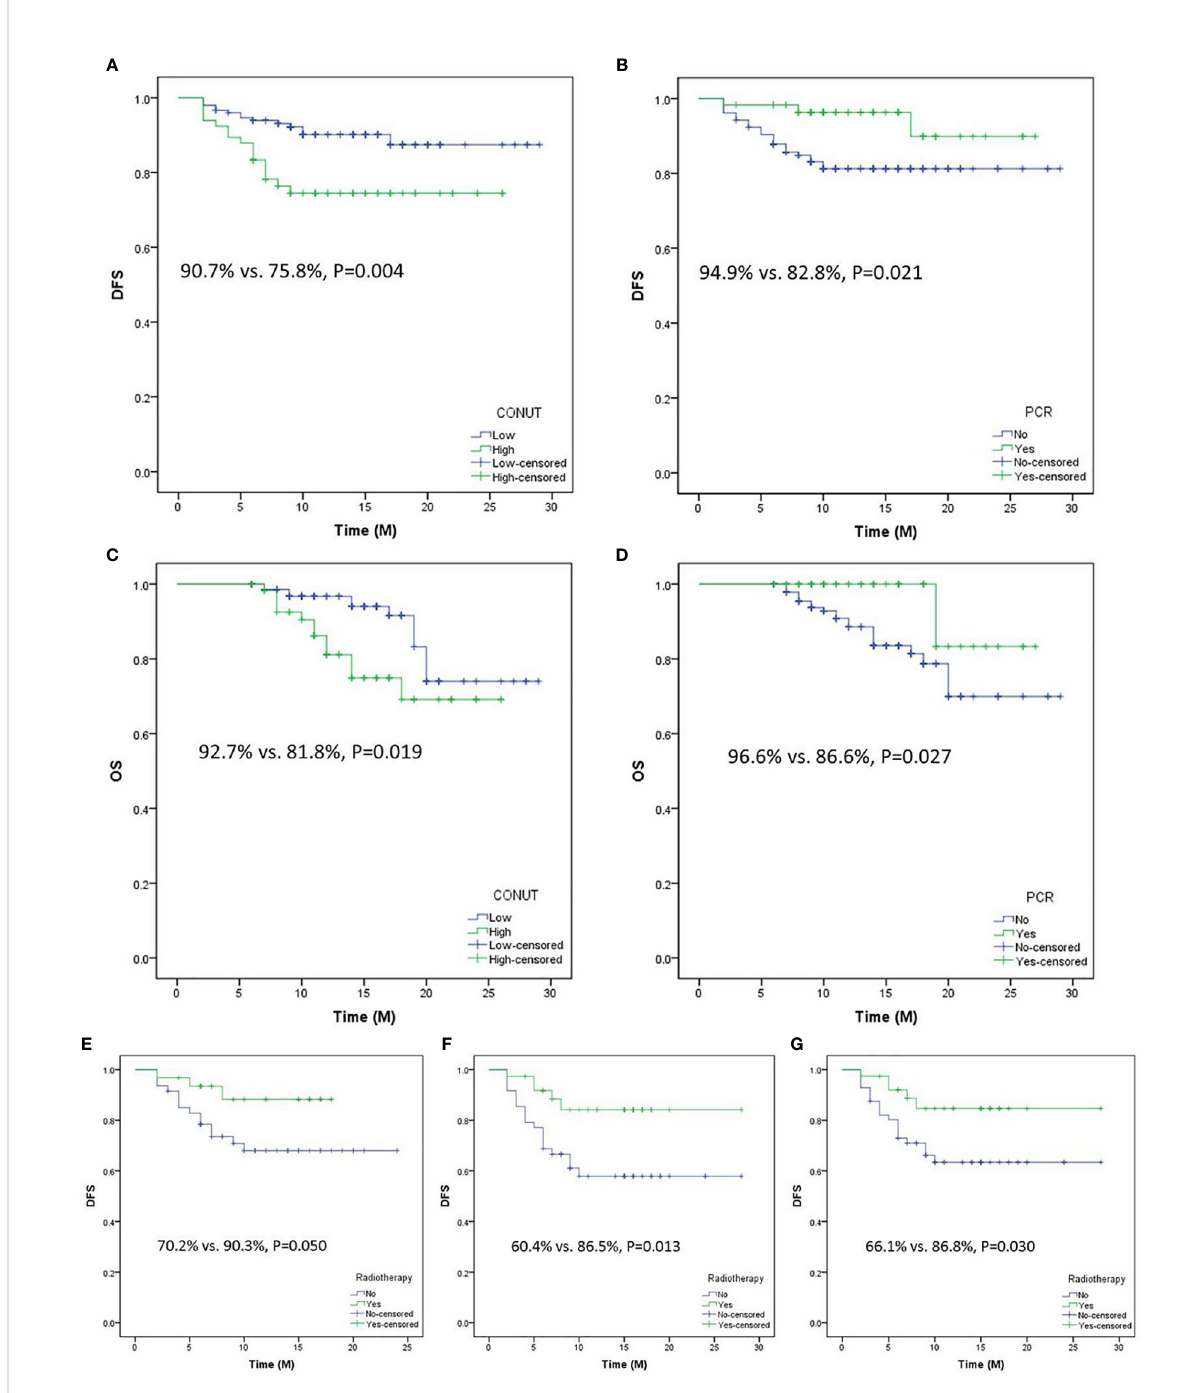
FIGURE 6 Disease-free survival (DFS) analyses grouped by CONUT (A) and pathologic complete response (pCR) (B) . Overall survival analyses grouped by CONUT (C) and pCR (D) . Subgroup analyses regarding DFS grouped by postoperative radiotherapy or not in ypT3-T4a (E) , yp N1-3 (F) , and ypTNM III-IVa (G)